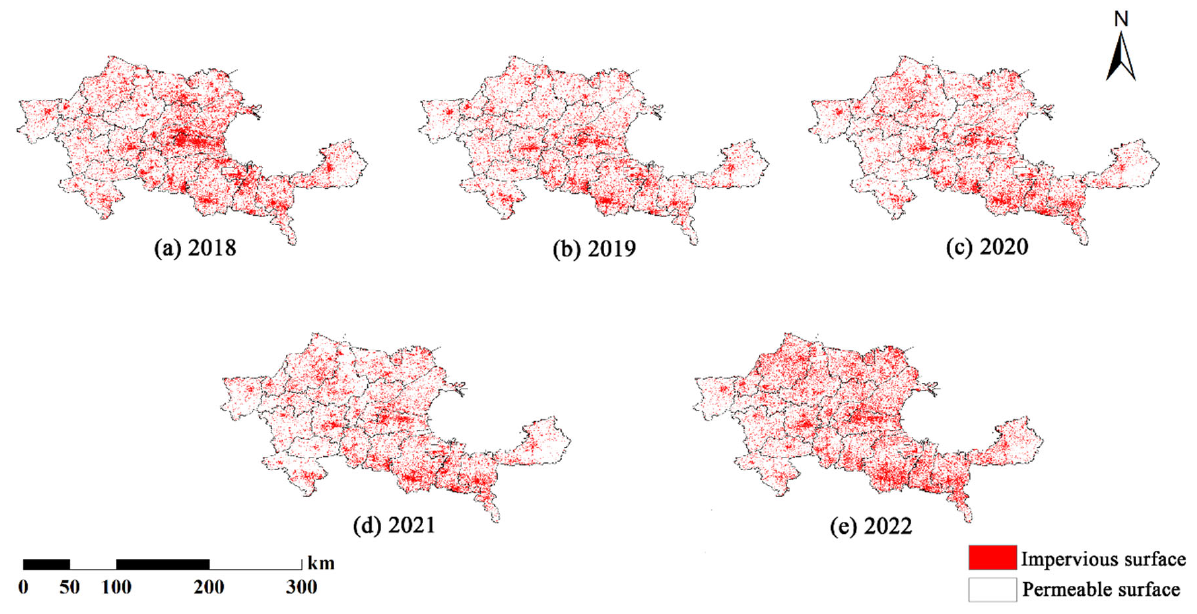
Figure 8. Spatial-temporal distribution of ISA over the last 5 years. Figure 8. Spatial ‐ temporal distribution of ISA over the last 5 years.